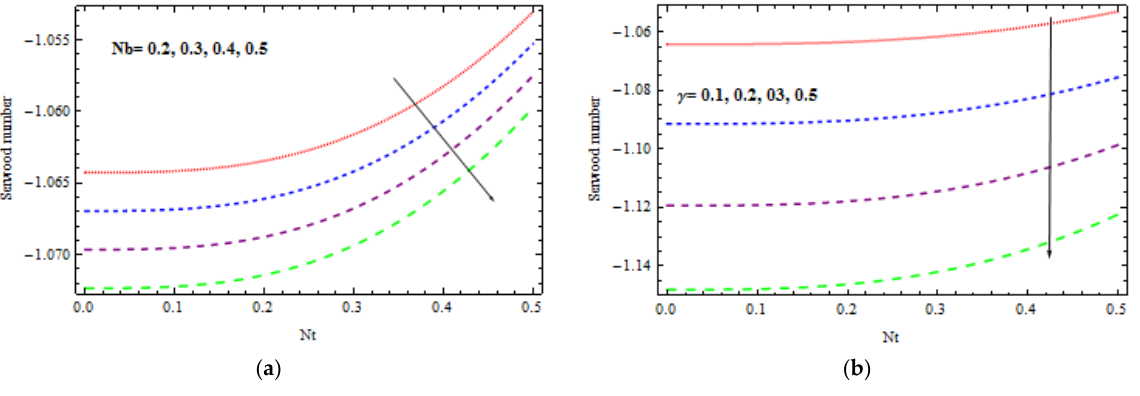
Figure 21. Variation of Sherwood number by ( a ) Nb, ( b ) 𝛾 .